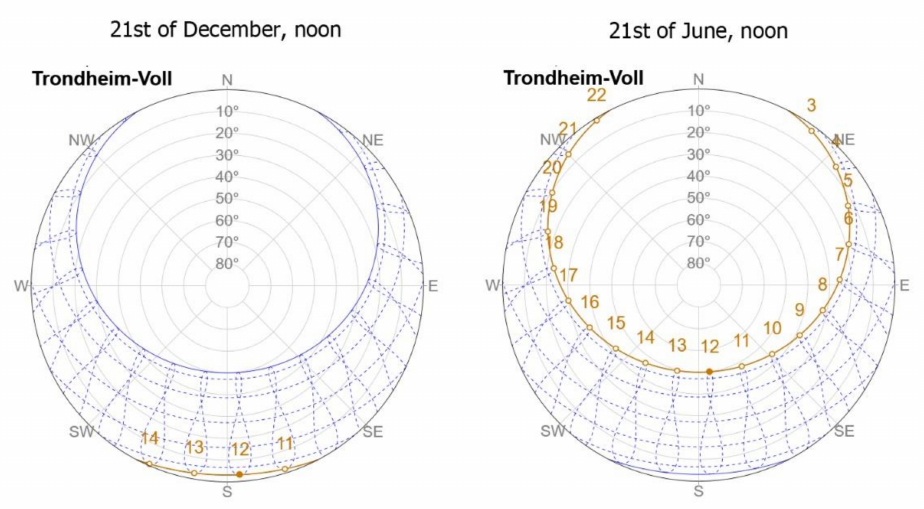
Figure 2. Solar paths for